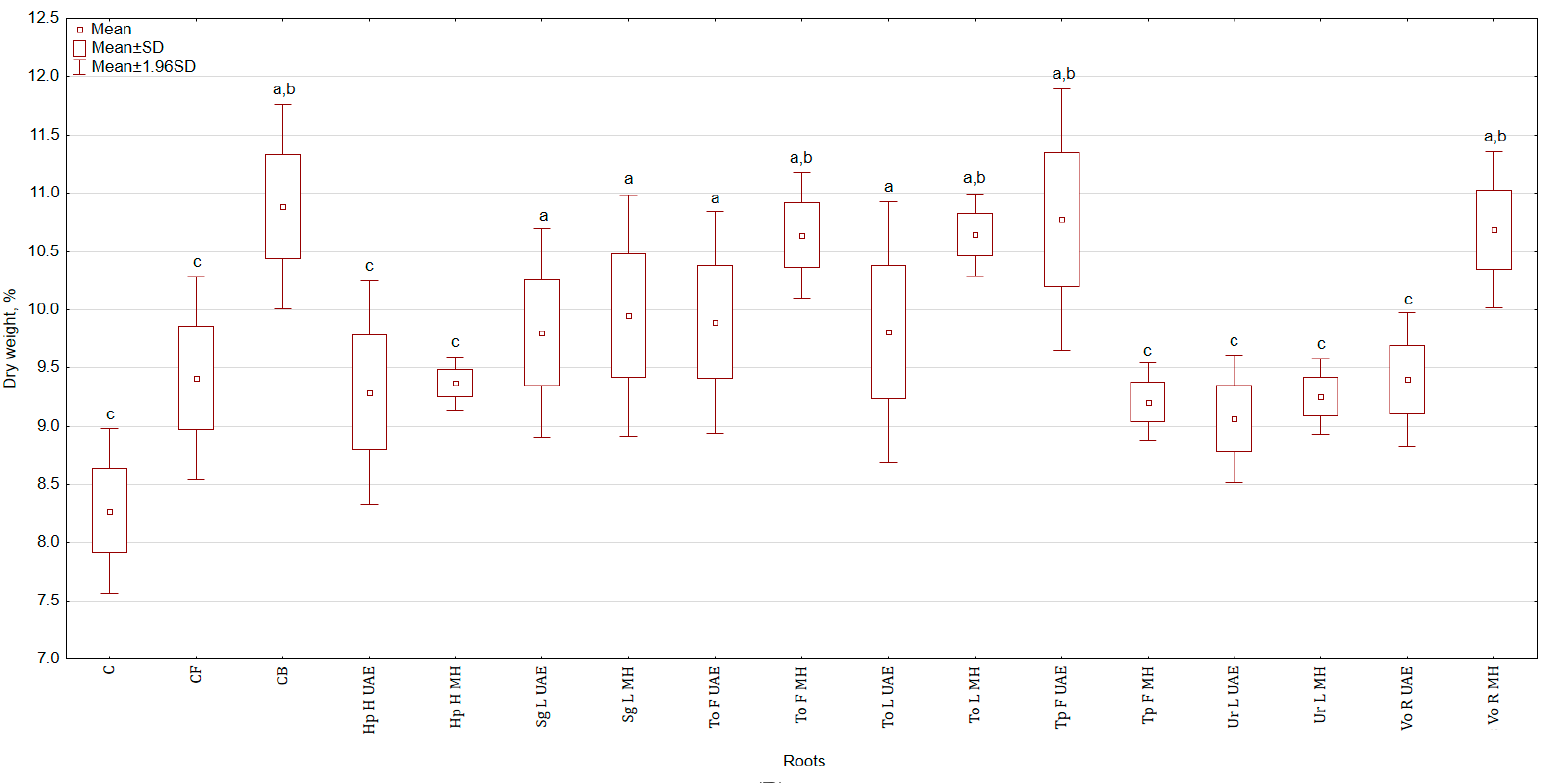
Figure 1. ( A ) Effect of the foliar application of botanical extracts on the dry weight of celeriac leaves rosette (N = 3). (a) Statistically significant differences ( p < 0.05) between the control group (C) and extracts. (b) Statistically significant differences ( p < 0.05) between water formulation (CF) and extracts. (c) Statistically significant differences ( p < 0.05) between commercial biostimulant (CB) and extracts. 1st term of leaves rosette collection—samples taken for analyses 7 days after the second spraying. 2 term of leaves rosette collection—samples taken for analyses after harvesting. Abbreviations: UAE, ultrasound assisted extraction; MH, mechanical homogenisation; Hp H, Hypericum perforatum L. (St. John’s wort, herb); Sg L, Solidago gigantea Ait. (giant goldenrod, leaf); To F, To L, Taraxacum officinale (L.) Weber ex F.H. Wigg (common dandelion, flower, leaf); Tp F, Trifolium pratense L. (red clover, flower); Ur L, Urtica dioica L. (nettle, leaf); Vo R, Valeriana officinalis L. (valerian, root). ( B ) Effect of the foliar application of botanical extracts on the dry weight of celeriac roots (N = 3).